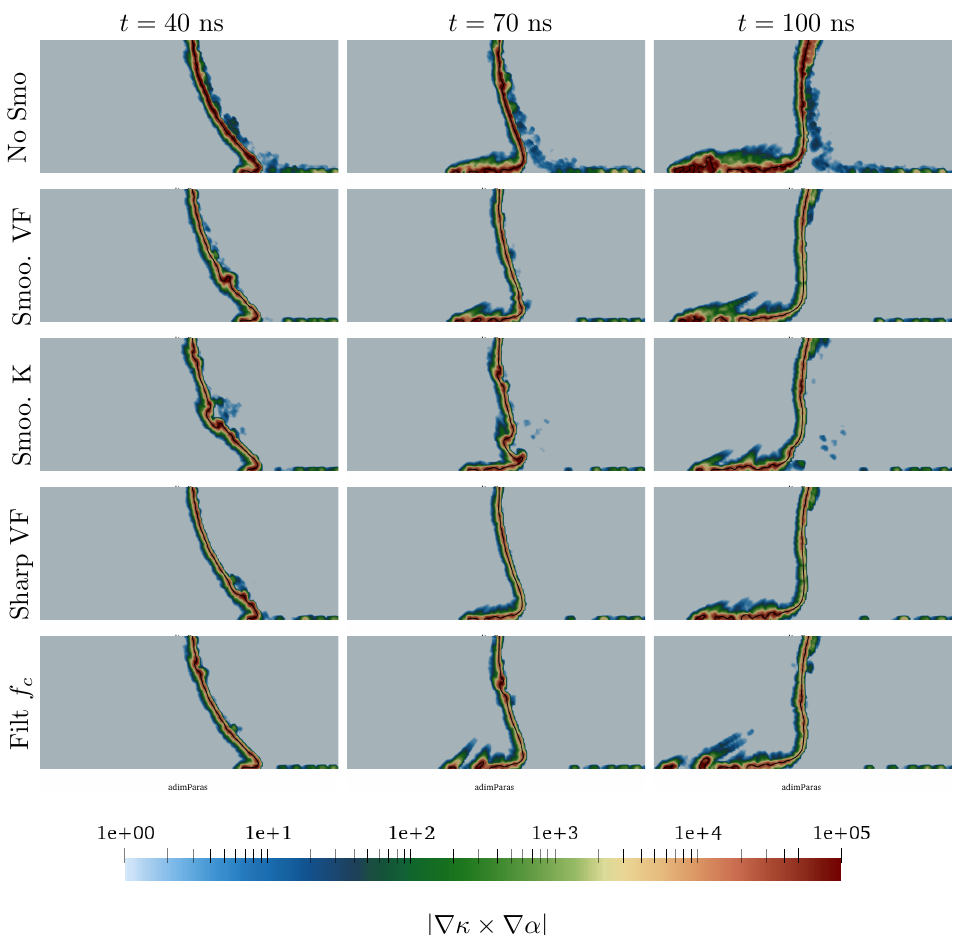
Figure 6. Contour plot of the droplet